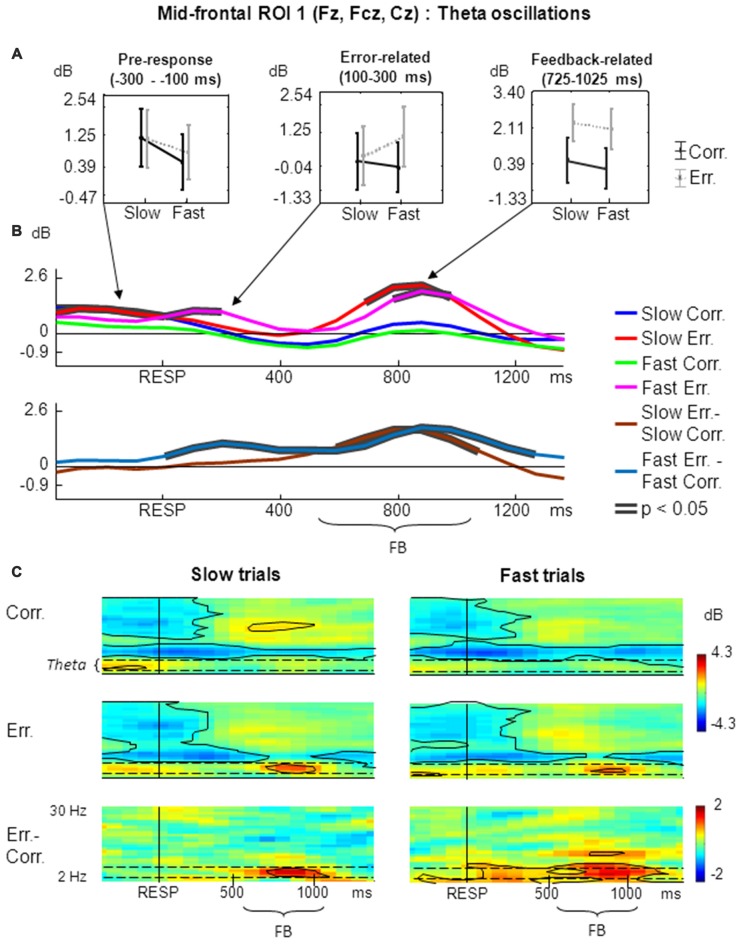
Non-phase-locked frontal midline theta (FMT) oscillatory activity at mid-frontal ROI 1 on fast and slow trials. (A) Graphs representing averaged event-related spectral perturbation (ERSP) data on slow correct, slow erroneous, fast correct and fast erroneous trials. Panels represent “pre-response”, “error-related” and “feedback-related” time windows correspondingly; data are plotted as mean ± standard error of mean. (B) Timecourses of ERSP modulations relative to response. (Top subpanel: slow correct, slow erroneous, fast correct and fast erroneous trials. Bottom subpanel: difference between slow erroneous and slow correct, and between fast erroneous and fast correct trials). Black contours overlaid on timecourse lines indicate statistical significance (p < 0.05, permutation statistics). “RESP”—behavioral response, “FB”—feedback. Time is shown relative to the behavioral response. (C) Time-frequency plots of oscillatory activity relative to response. Left panels: ERSP distribution on slow trials. Right panels: ERSP distribution on fast trials. Horizontal dashed lines over ERSP plots indicate theta frequency range. Within each panel: “Corr.”: dynamics of ERSP on correct trials; “Err.”: dynamics of ERSP on erroneous trials; “Err.–Corr.”: dynamics of ERSP difference between erroneous and correct trials. Black contours show significant time-frequency areas (p < 0.05, permutation statistics). “RESP”—behavioral response, “FB”—feedback. Time is shown relative to the behavioral response.